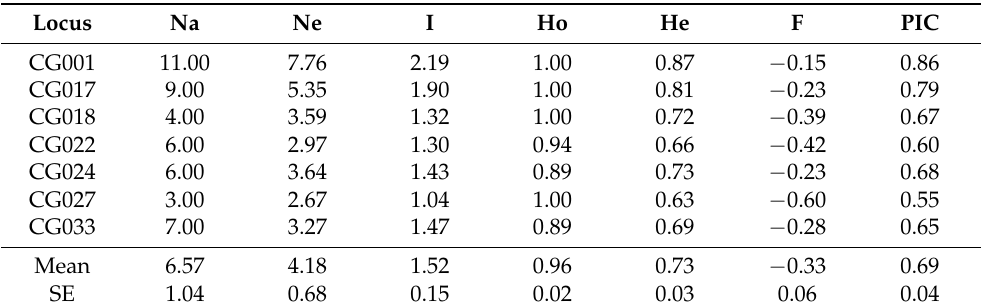
Table 5. Genetic diversity parameters generated by simple sequence repeat markers among 18 spider plant